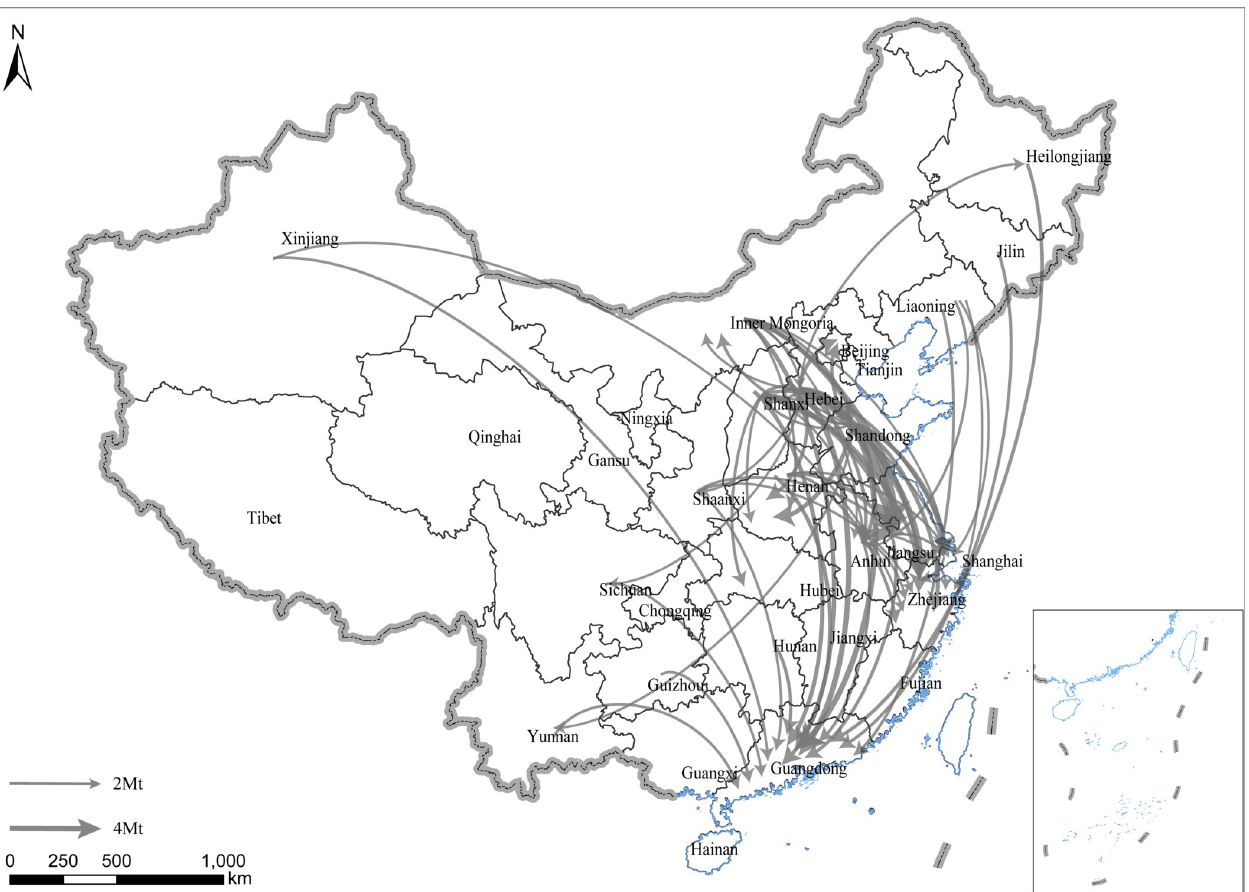
Fig 3. Interprovincial embodied CO 2 flow of China in 2012. Only flows exceeding 2 Mt are included. The arrow indicates the direction of each flow. The width of the flows indicates the amount. Republished from standard map service of NGCC [28] under a CC BY license, with permission from Chinese National Basic Geographic Information Center, original copyright